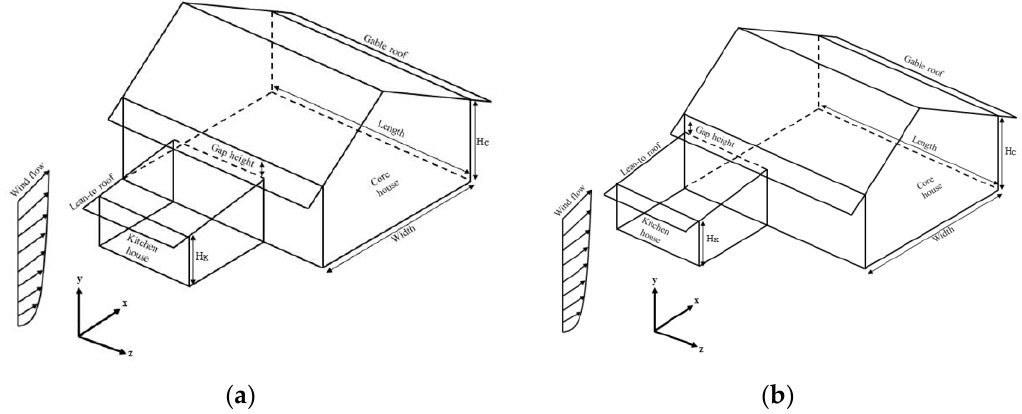
Figure 6. A diagram of a Malaysian rural house with a kitchen at the ( a ) center and ( b ) edge.